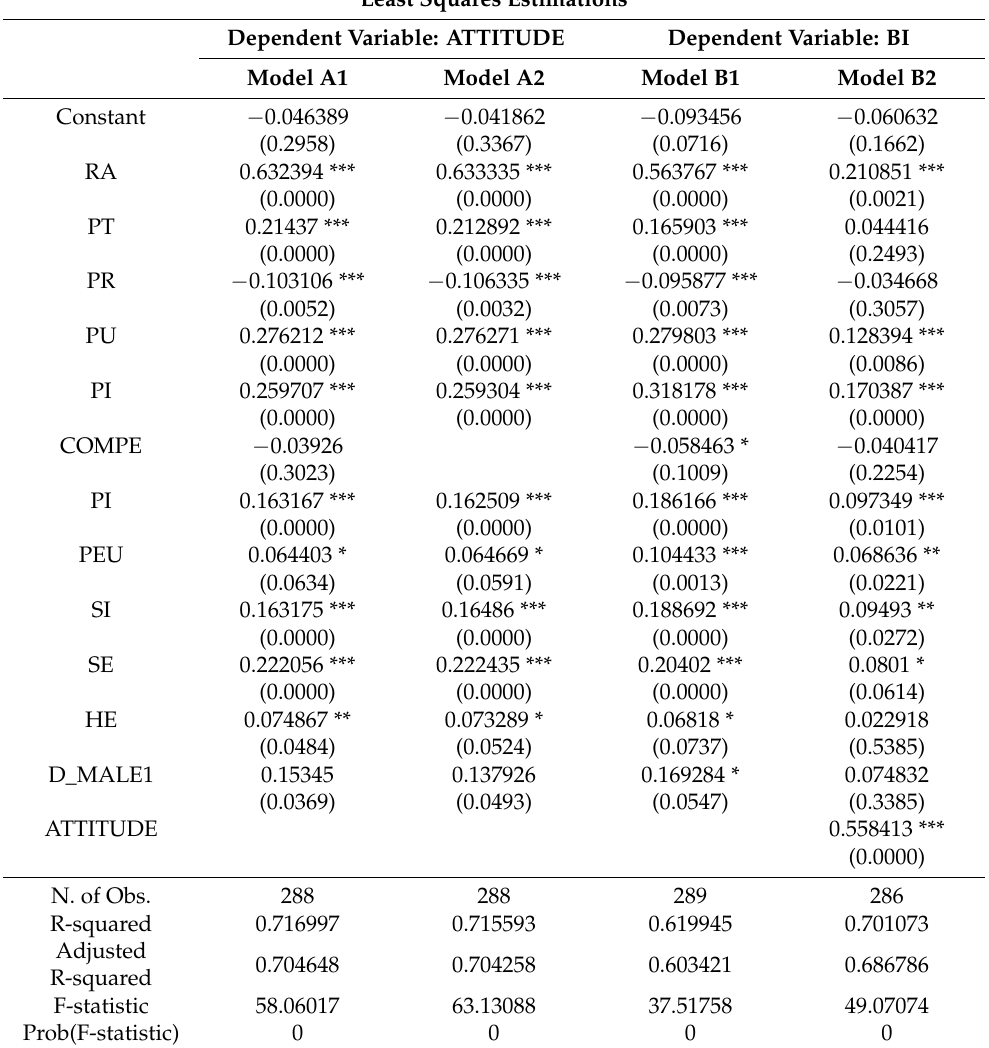
Table 7. Least Squares Estimations.